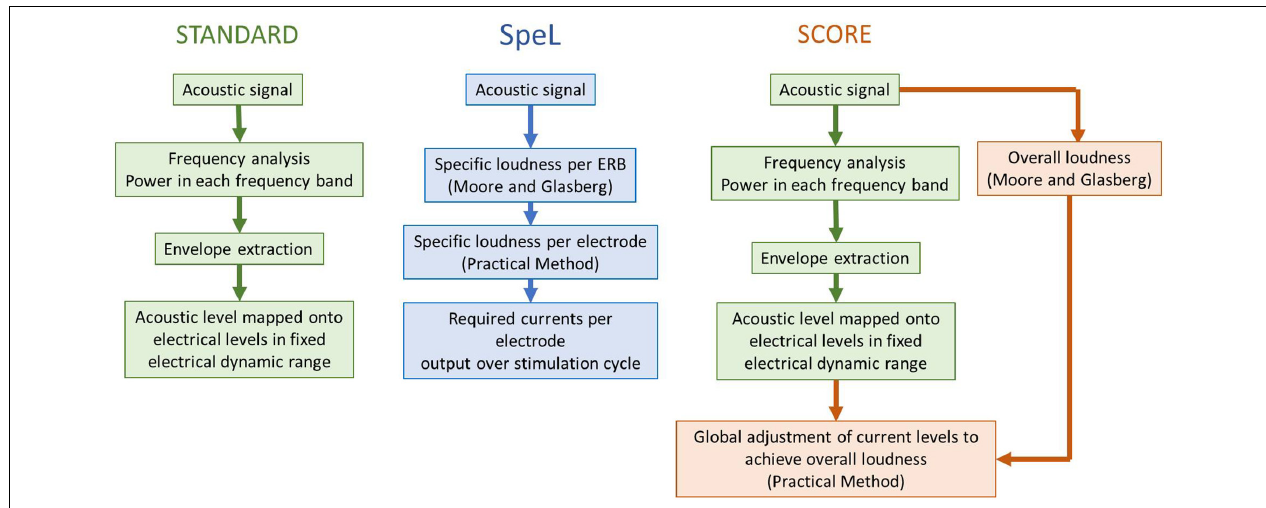
FIGURE 6 | Schematic that illustrates the essential principles of the signal processing strategies SpeL and SCORE in relation to standard clinically used signal processing strategies. The flowchart illustrates the differences in processes that occur for each stimulation cycle or within each update window. The reader is referred to the original articles (McDermott et al., 2003; Varsavsky and McDermott, 2013) for a detailed technical description of the strategies.